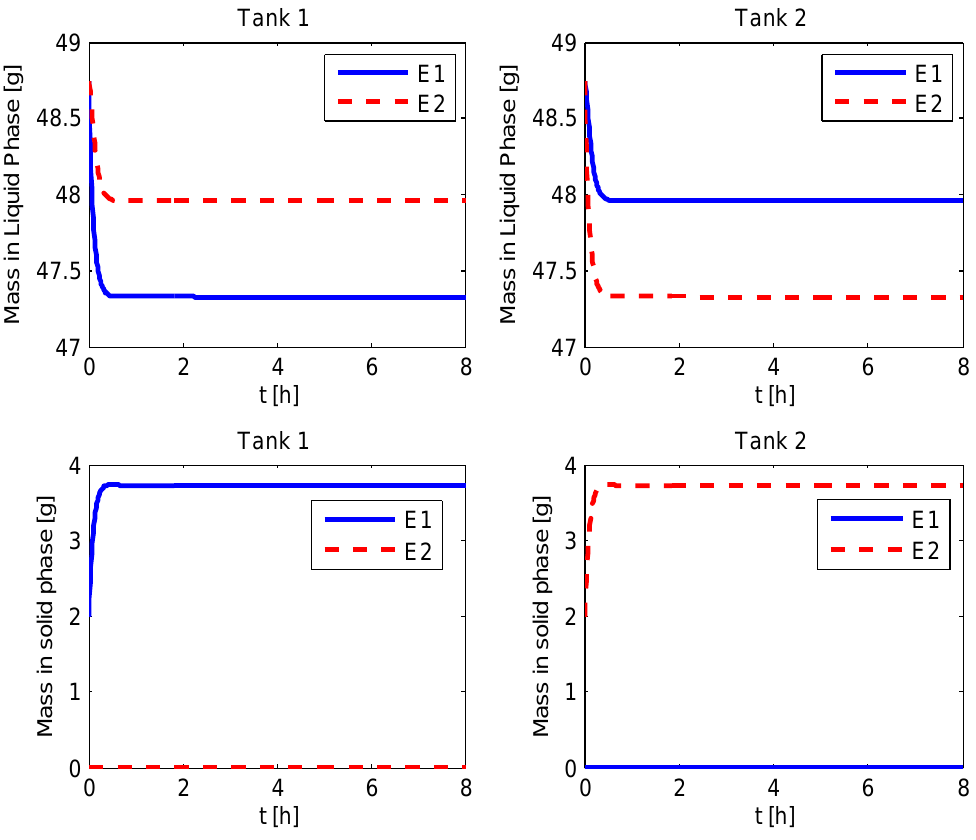
Figure 2. Evolution of mass in liquid and solid phases for the coupled preferential crystallization in MSMPR crystallizers